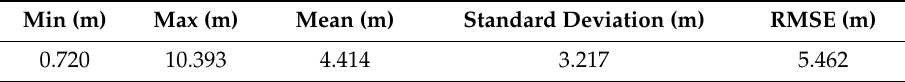
Table 1. Statistical values of CP residuals for the topographic map.